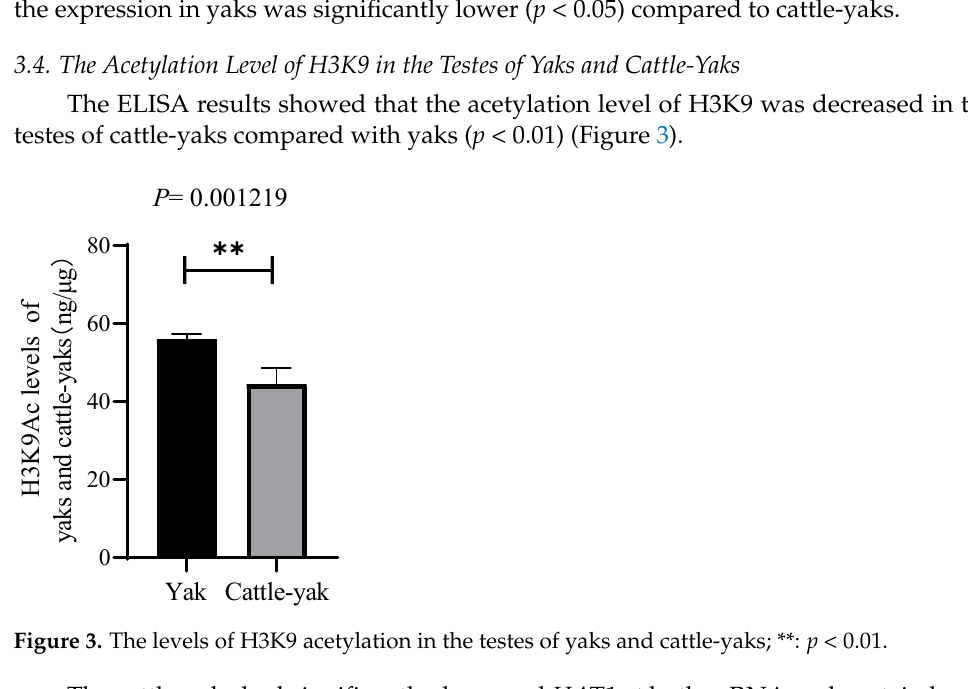
Figure 3. The levels of H3K9 acetylation in the testes of yaks and cattle-yaks; * p < 0.05 and **: p <